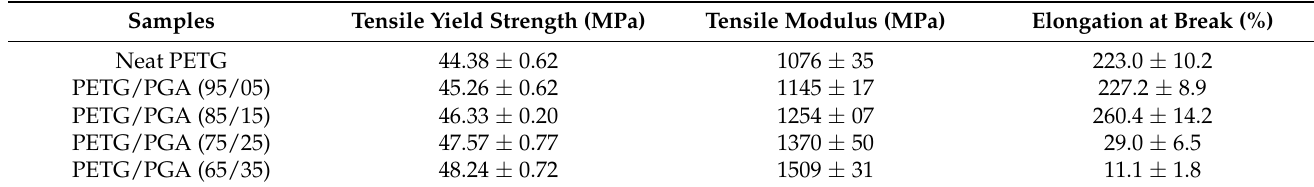
Table 2. Tensile performance of neat PETG and PETG/PGA (y/z)